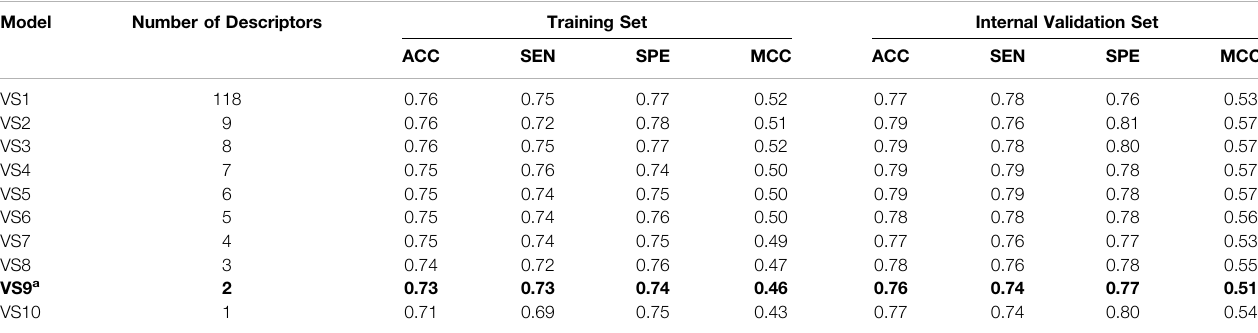
TABLE 2 | Performance of VolSurf-based PLS-DA models.